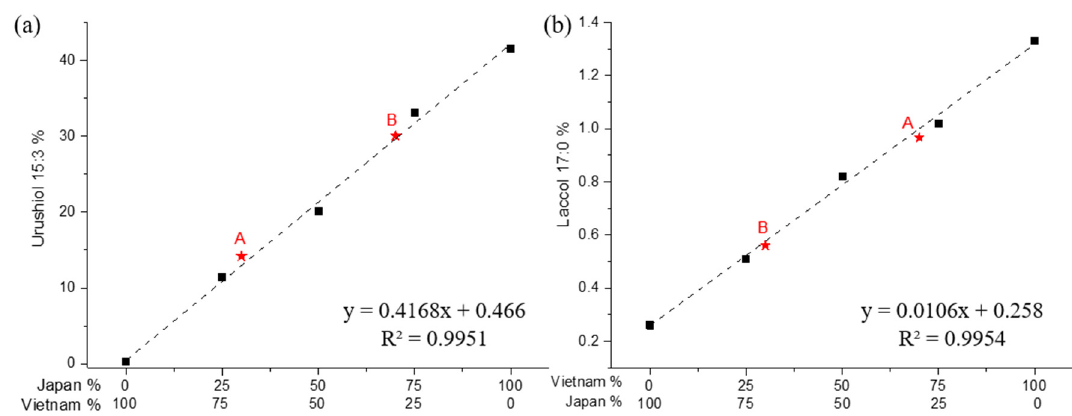
Figure 6. Calibration curves of the compositional ratios of blended Japanese and Vietnamese lacquers as a function of standard catechol peaks using HPLC: ( a ) 3-pentadecatrienyl; ( b ) 3-heptadecyl.